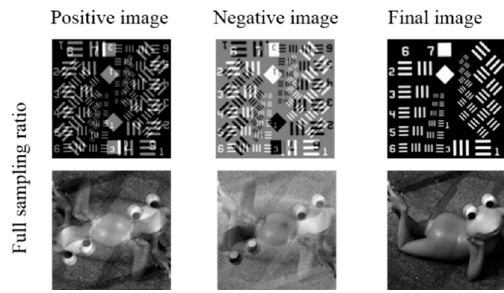
Figure 2. Positive and negative images with a full sampling ratio.